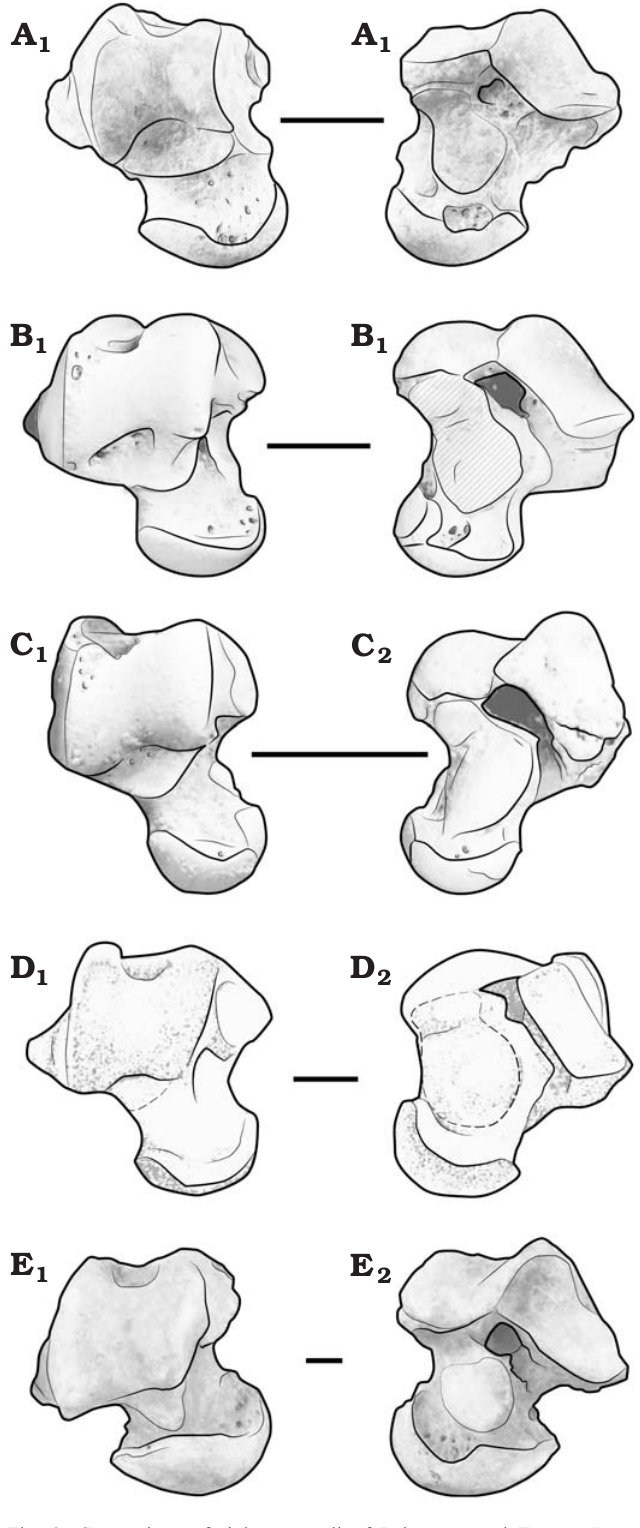
Fig. 3. Comparison of right astragali of Paleocene and Eocene “con- dylarths”: Hilalia saribeya ( A ), Pleuraspidotherium aumonieri ( B ), Orthaspidotherium edwardsi ( C ), Meniscotherium sp. ( D ), Arctocyon pri- maevus ( E ), in dorsal (A 1 –E 1 ) and plantar (A 2 –E 2 ) views. Adapted from Argot (2013), Ladevèze et al. (2010), Williamson and Lucas (1992). Scale bars 5